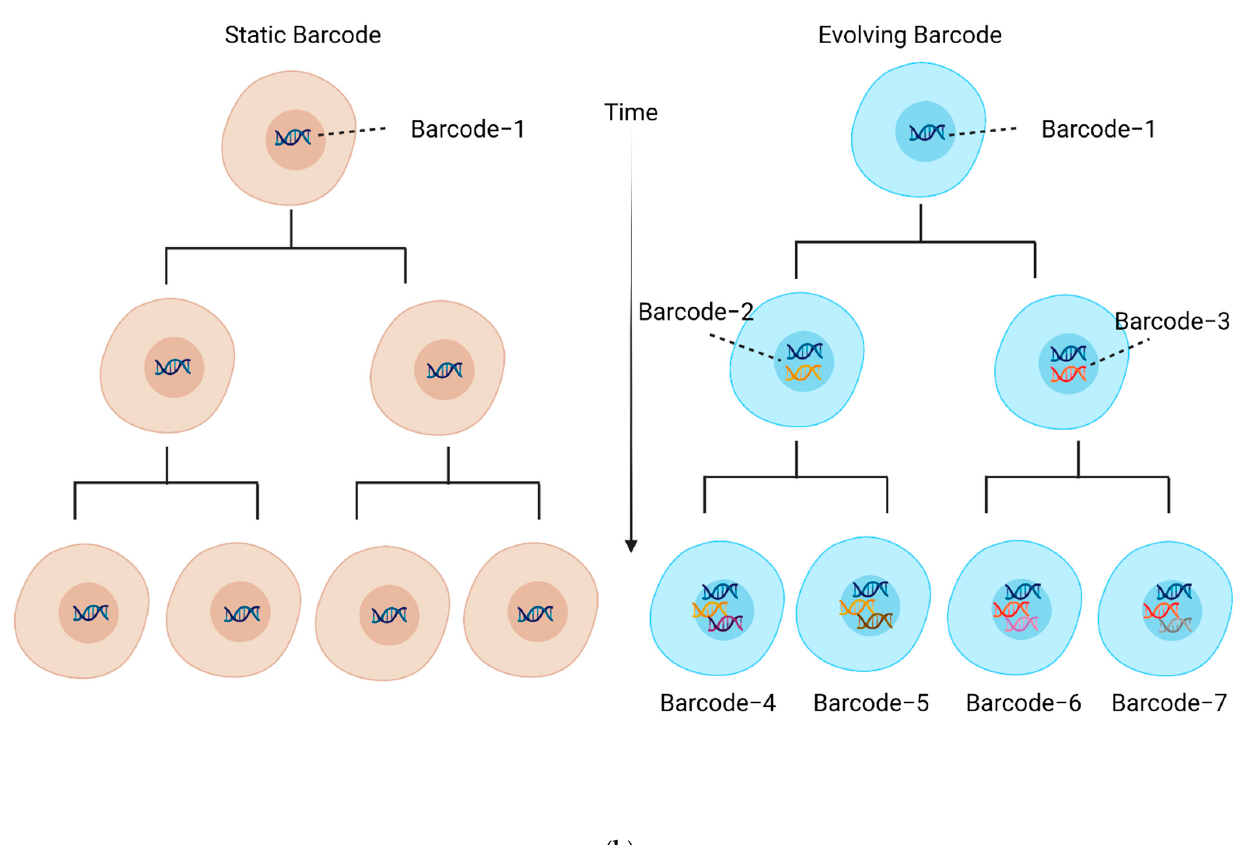
Figure 3. ( a ) Schematic representation of Slide-seq. Microbeads in each well decorated with a unique DNA sequence are deposited. Samples are placed on the slide, and reverse transcription follows. Then, the library is amplified, and single-cell RNA-sequencing is performed. In the end, projected cell types in the microwell are determined by matrix transformation and assignment of the sequenced datasets to Slide-seq beads. (The figure was created with BioRender.com (accessed on 24/10/2021)). ( b ) DNA static barcode lacks the resolution of cell heterogeneity ( left ). In contrast, evolving DNA barcodes provide a higher resolution of cell heterogeneity ( right ). Barcodes repeatedly label a dividing cell clone, giving every progeny a distinct identity, in theory, at sequential levels of lineage hierarchy. (The figure was created with BioRender.com (accessed on 24/10/2021)).